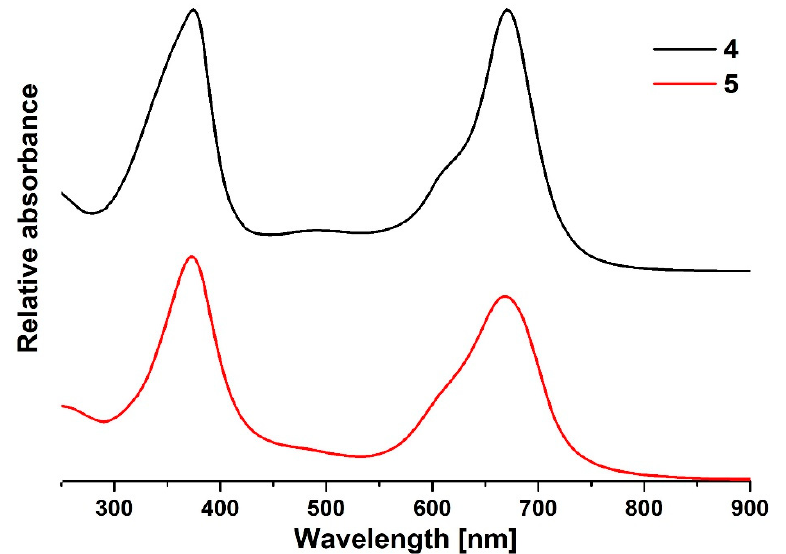
Figure 1. The UV–Vis spectrum of Pz 4 (black line) and Pz 5 (red line) in